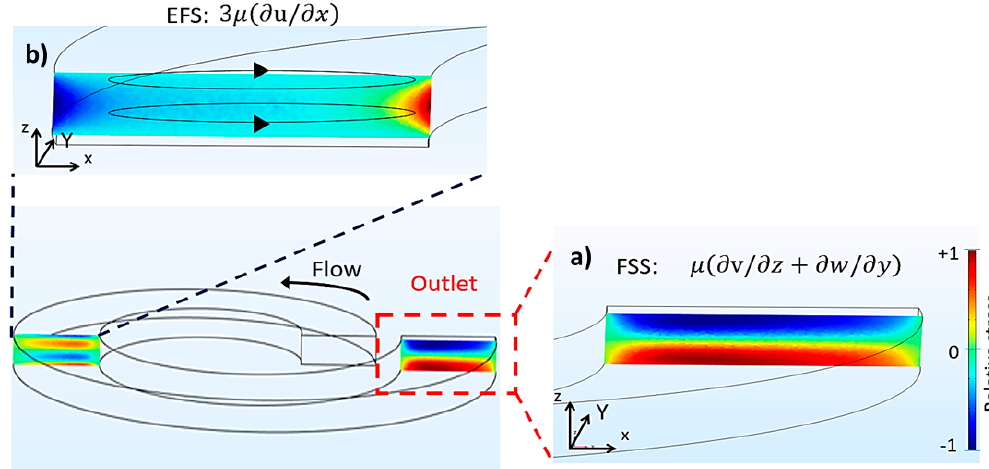
Figure 4. The formations of two major hydrodynamic shear stresses: fluid shear stress (FSS) and extensional fluid stress (EFS) in our predesigned Archimedean spiral microchannel (ASM) conducing to cell degeneration and necrosis of the sorted MCT cells. ( a ) The fluid shear stress was mainly maximal at the upper and lower perimeters, but in opposite directions. ( b ) The extensional fluid stress maximally took place at the lesser curvature of the ASM.